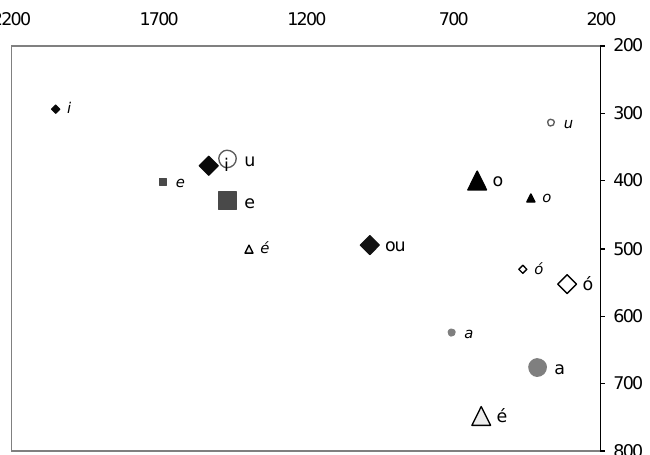
Figure 8: Vowel Space of Speaker